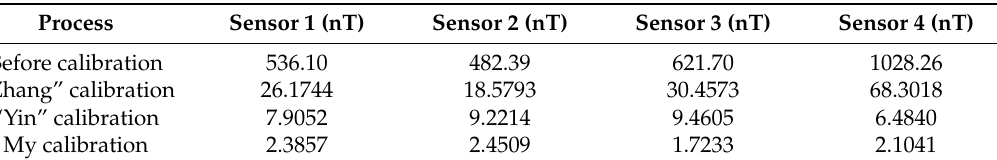
Figure 9. Comparison of TMI before and after calibration in the experiment. Table 4. RMSE of TMI before and after calibration in the experiment.